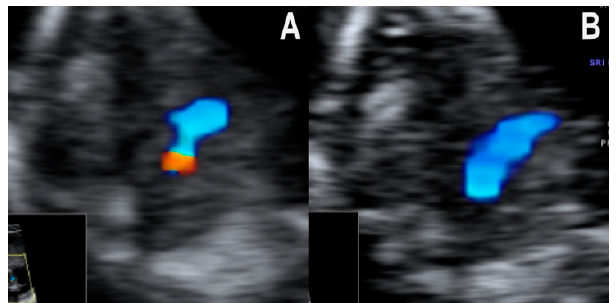
Figure 3. Color doppler flow patterns seen in the three-vessel and trachea view in the case of CAT. ( A ): Pulmonary arteries arising from the vessel. ( B ): The straight course of the vessel through the mediastinum.